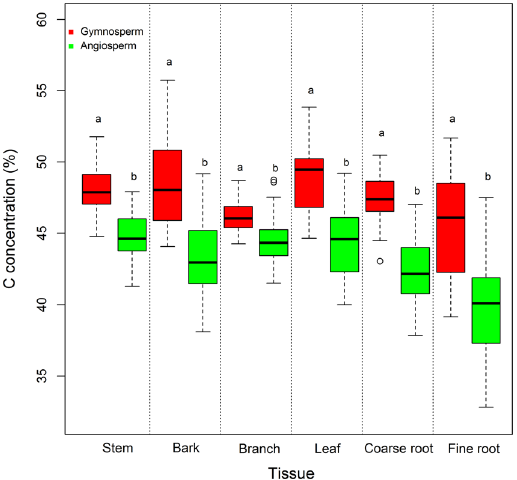
Figure 3. Comparison of C concentrations in stems, bark, branches, leaves, coarse roots and fine roots among functional types. For the boxplots: circles are outliers; vertical bars are data ranges defined as 1.5 × the inter-quartile range; horizontal lines within the boxes are median values; and the upper and lower bounds of the boxes are the third and first quartiles, respectively. Letters indicate significant difference at P < 0.0001 (gymnosperm, n = 28; angiosperm, n =